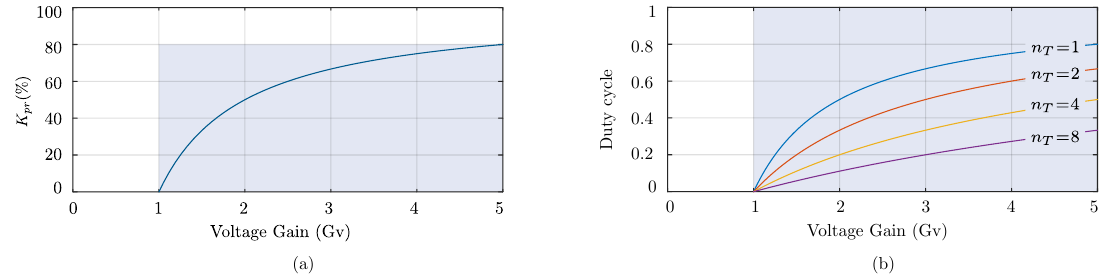
Figure 3. ( a ) Partial power operation range of the Step-Up Partial Power Converter (PPC). ( b ) Operation range of the Step-Up Flyback based PPC for different transformer turns ratio n T